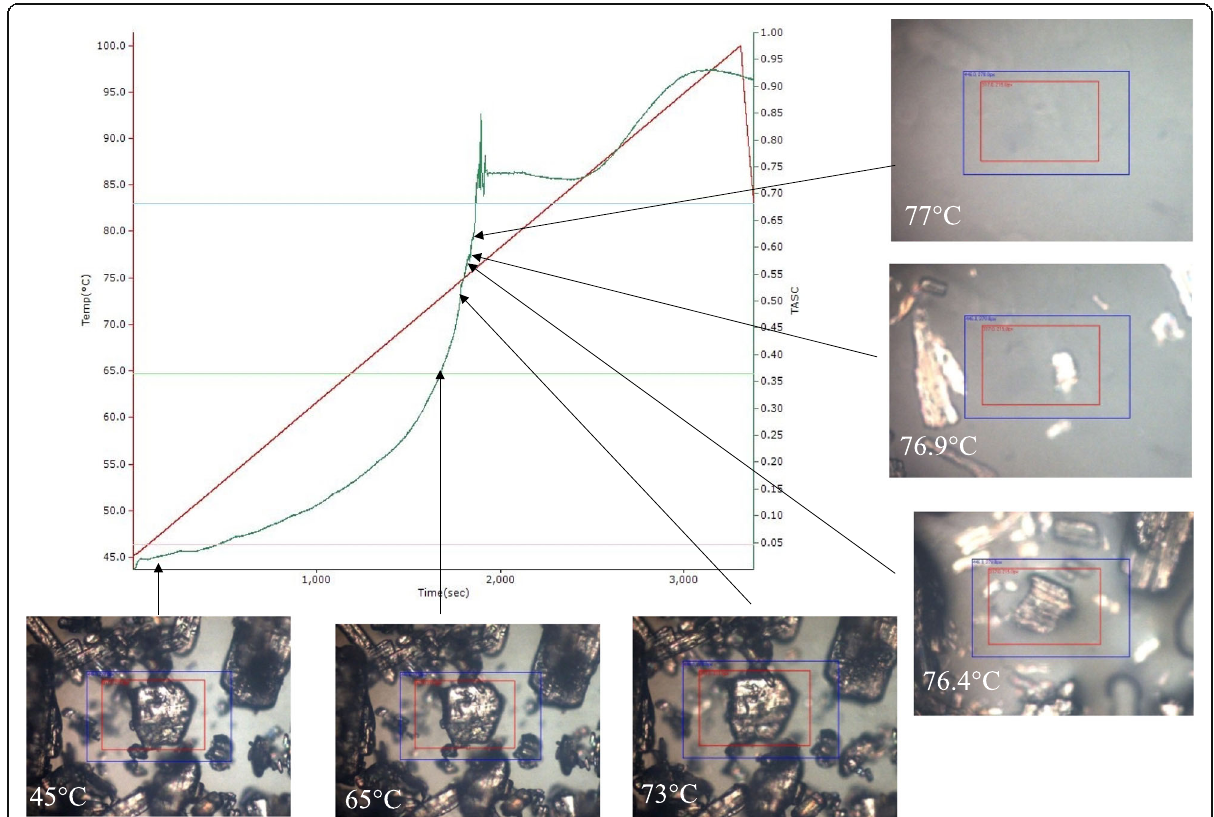
Fig. 10 TASC curve and HSM micrographs at different temperatures during melting of Ibuprofen. Melting starts at 65 °C and complete melting was observed at 77